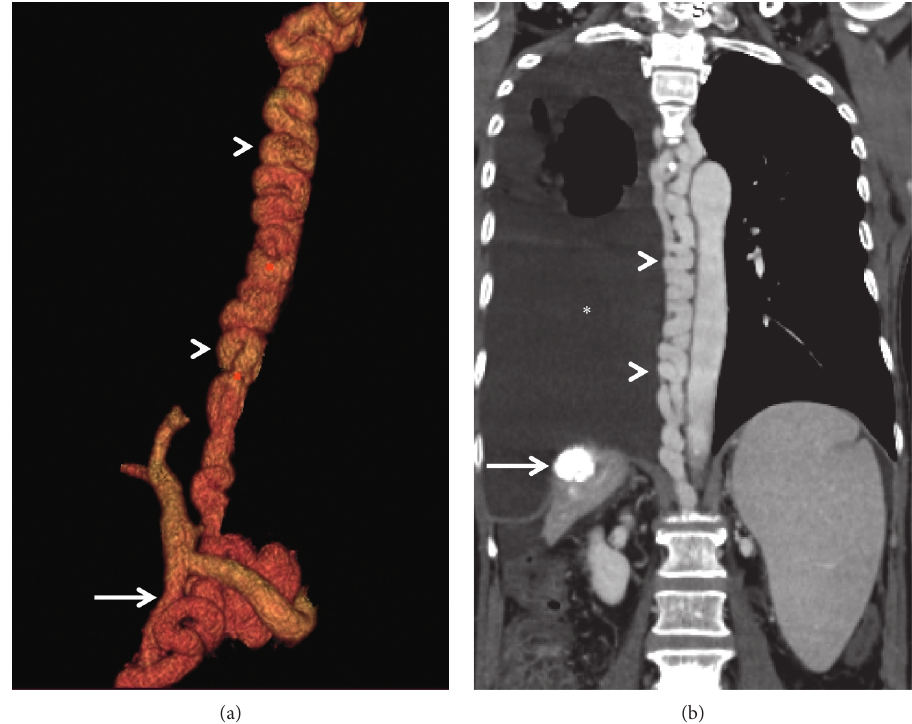
Figure 7: Volume rendered CECT image (a) showing a mesoazygos shunt (arrowheads). Solid arrow shows the superior mesenteric vein. Coronal MIP image (b) of the same patient showing the thoracic portion of the shunt (arrowheads) with massive hepatic hydrothorax (asterisk). Changes of prior transarterial chemoembolization are also noted (solid